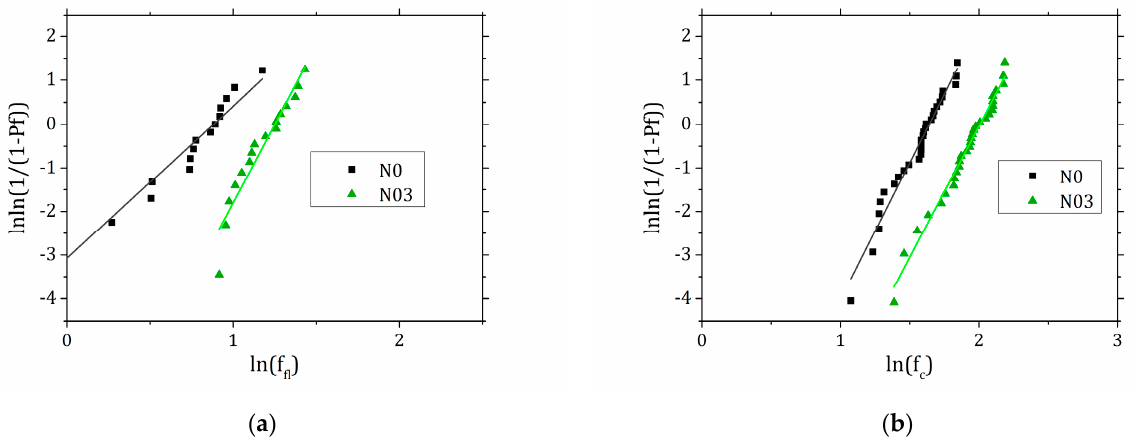
Figure 13. Linear fit of the experimental data from the three-point bending ( a ) and compression ( b ) tests analysed with Weibull statistics.